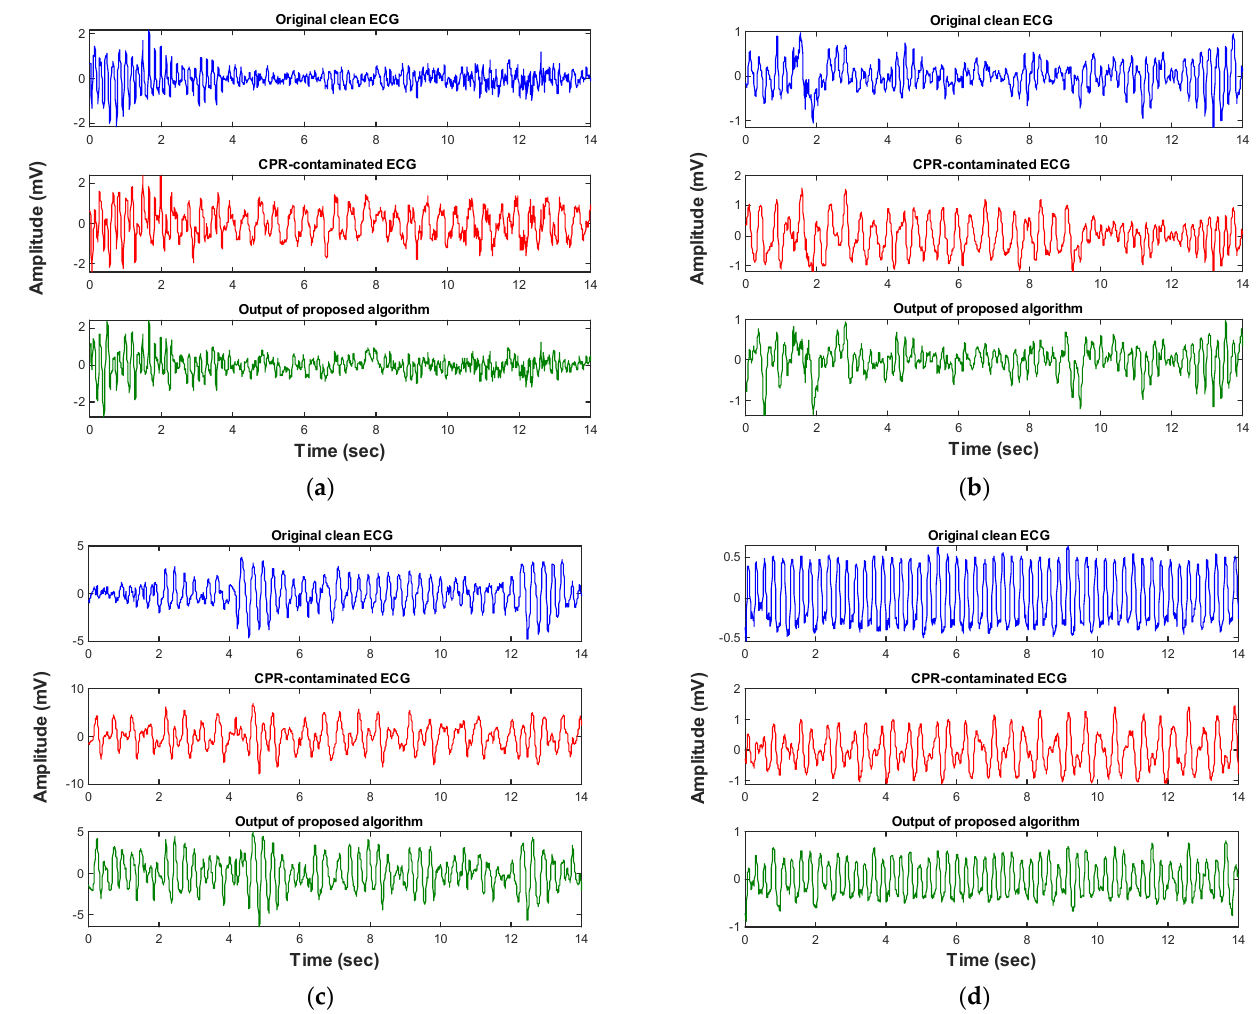
Figure 8. ( a – d ) Show the performance of the condition-based filter on four different representative shockable ECG rhythm types (test set). Each panel represents the ECG data segment of a different subject. Table 4. Results of the proposed filtering algorithm on the validation